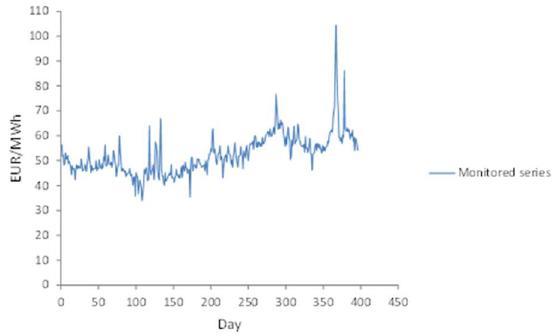
Figure 3. Daily monitored series of electricity price.